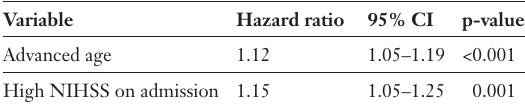
Independent predictors of early mortality in 467 patients with first-ever ischaemic